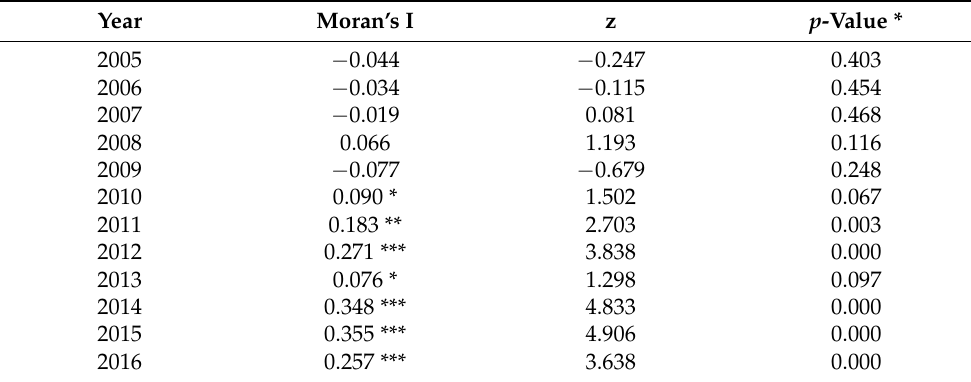
Table 4. Moran’s I